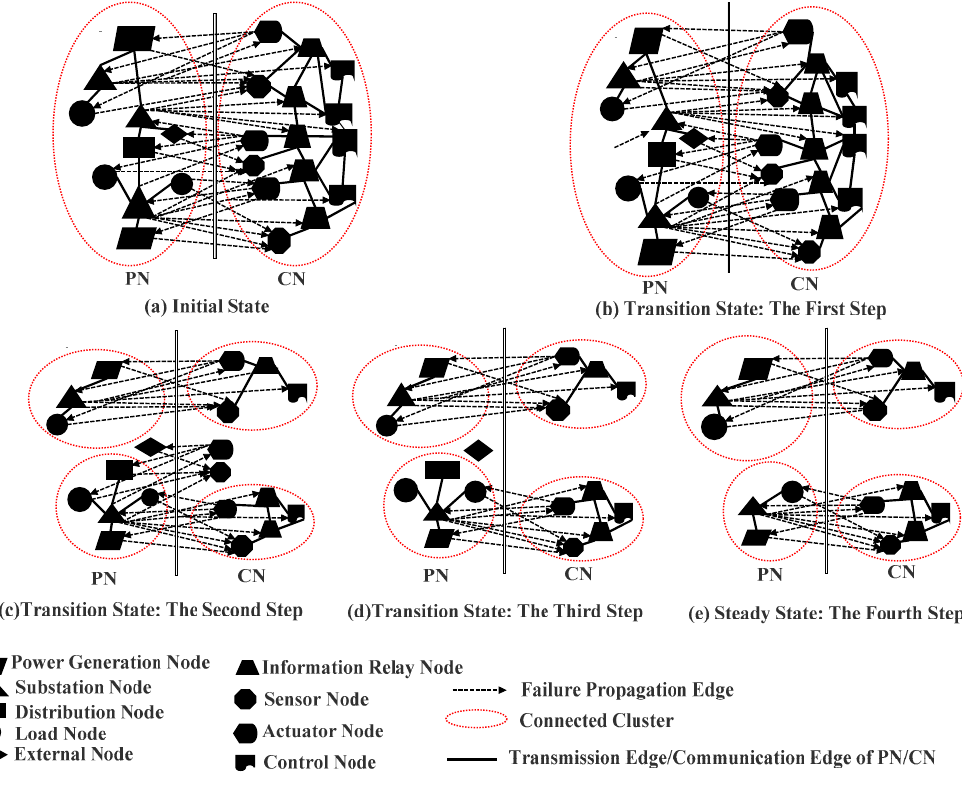
Figure 2. Simple running example of a cross-domain cascading failure (CCF) in an ADN.